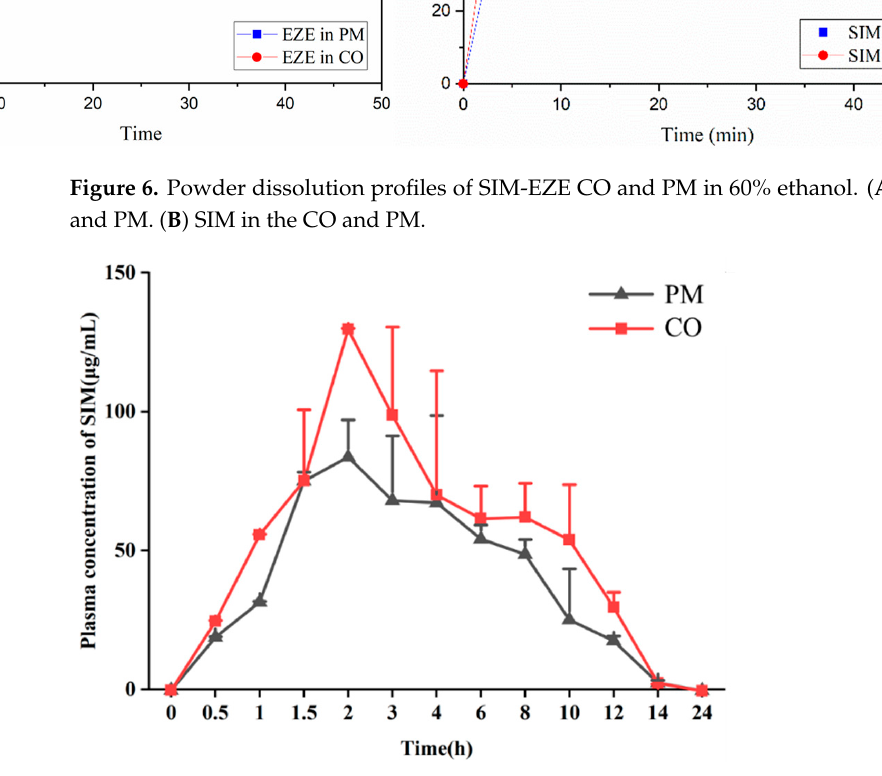
Figure 7. Mean plasma concentration vs. time curve of SIM in mice after oral administration of CO or PM (data are shown as mean ± SD, n = 8). Table 1. Pharmacokinetic parameters of SIM in the CO or PM.